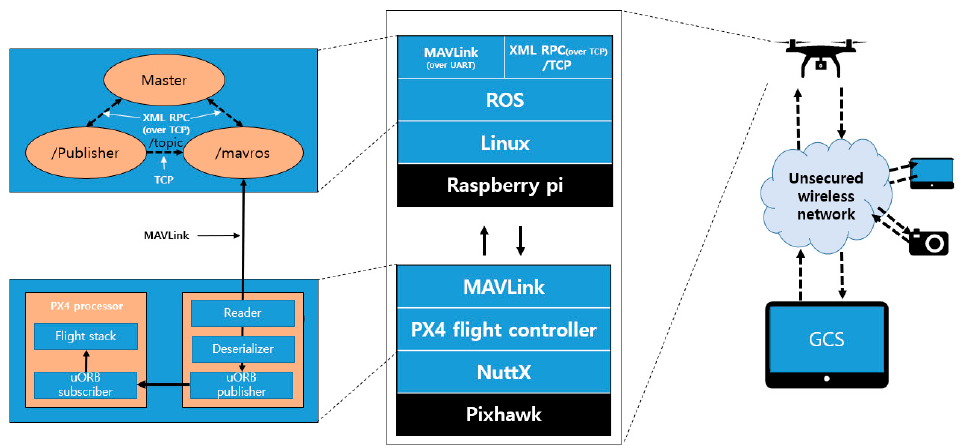
Figure 11. Experiment environment.